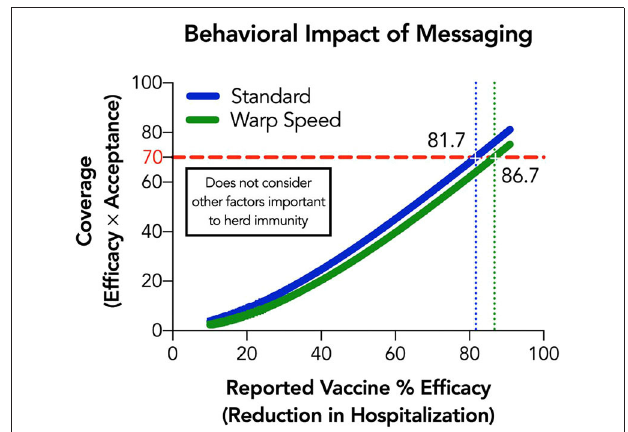
FIGURE 3 | Estimated vaccine coverage by efficacy and vaccine development process. Horizontal reference lines (red) indicate a 70% coverage level and vertical reverence lines depict the vaccine efficacy associated with 70% coverage for both standard (shaded blue) and expedited (shaded green) development processes; adjacent numerical values indicate exact solutions for efficacy at 70% coverage per